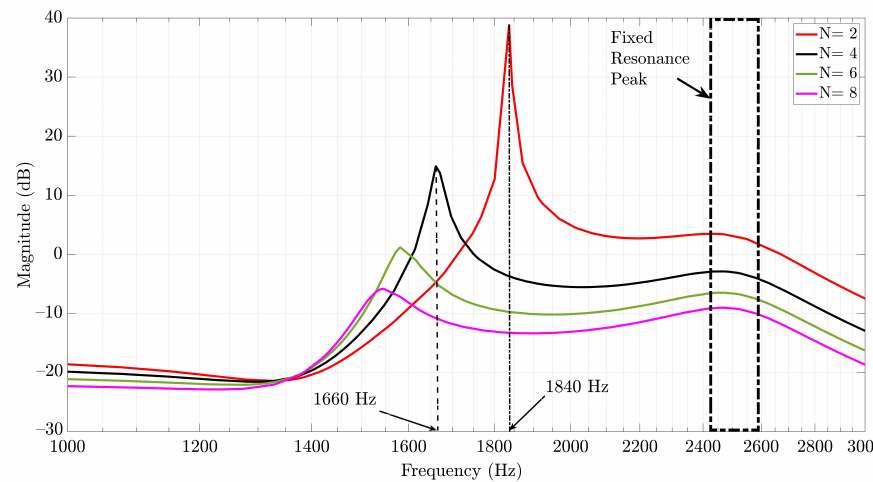
Figure 11. Frequency response of the interactive current resonance among the VSIs.